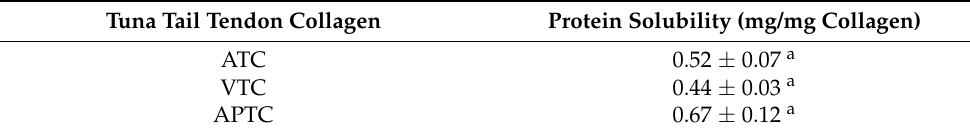
Table 3. The soluble-protein content of tuna-tail-tendon collagens. Tuna Tail Tendon Collagen